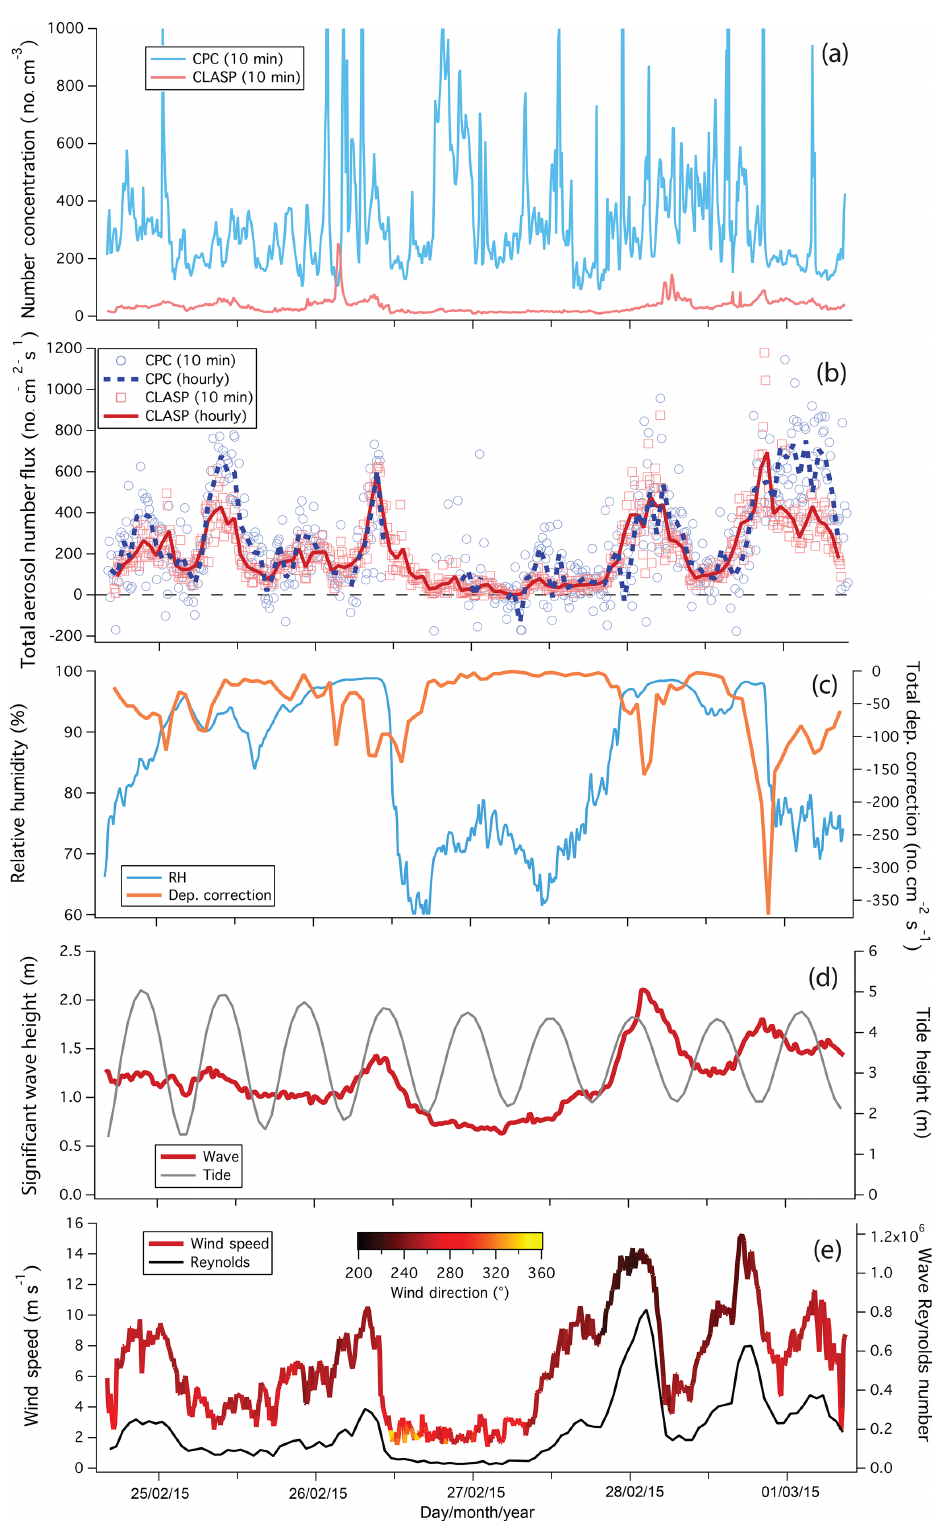
Figure 3. Times series of (a) CPC and integrated CLASP aerosol number concentration, (b) total aerosol number source flux from the CPC and CLASP, (c) relative humidity and the integrated CLASP deposition correction, (d) significant wave height and tide height, and (e) wind speed (colour-coded by wind direction) and wave Reynolds